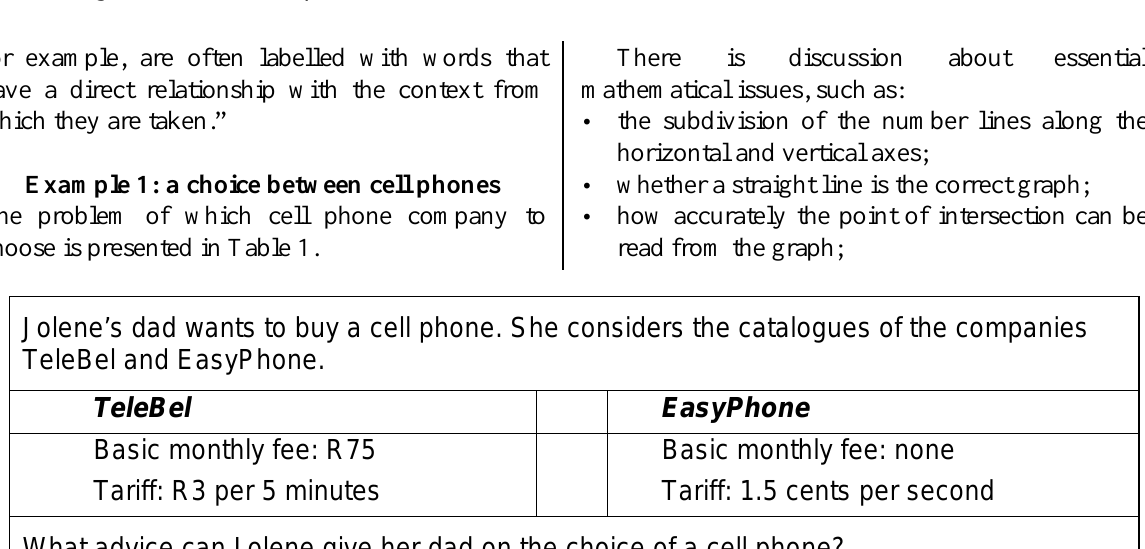
Choice between cell